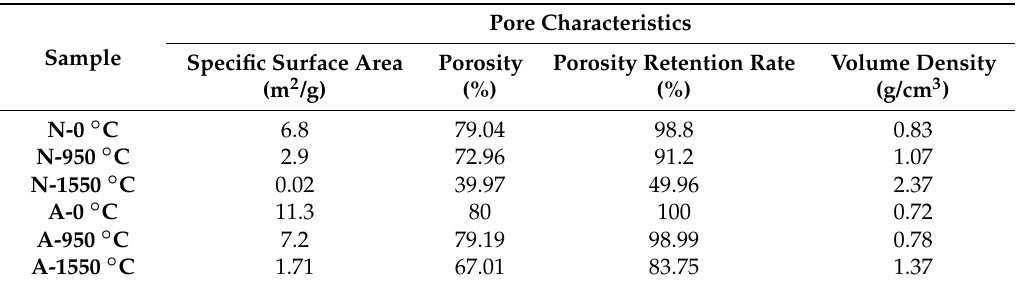
Table 1. Physical properties of porous ceramics with and without assembly